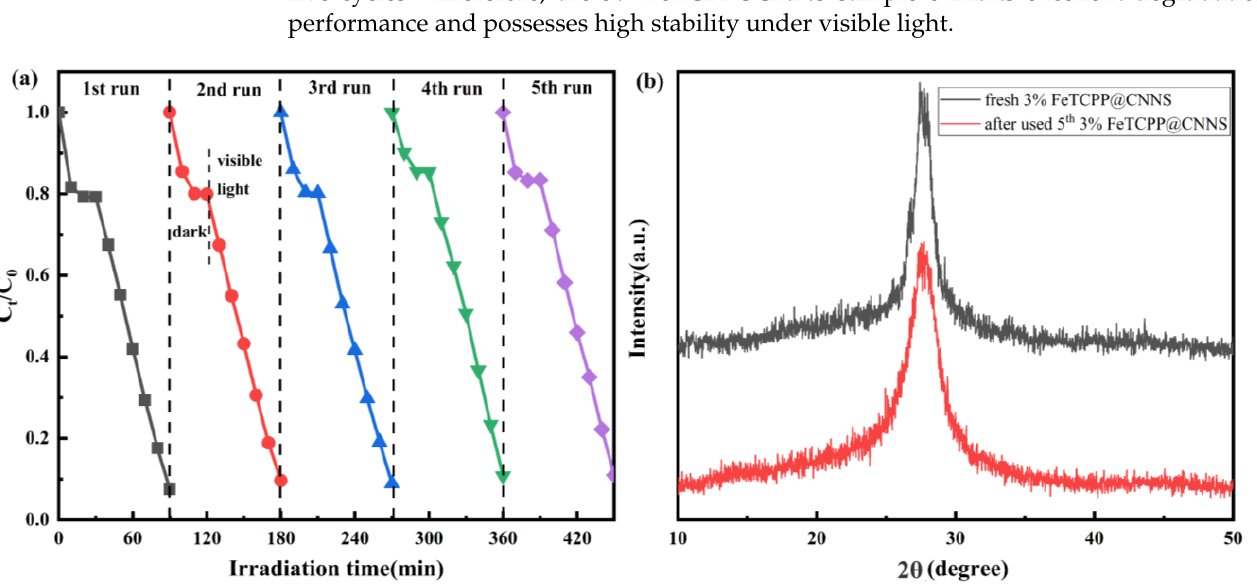
Figure 9. The 3% FeTCPP@CNNS photocatalytic degradation of 4-NP ( a ) cycle test curve and ( b ) XRD contrast after 5 cycles.